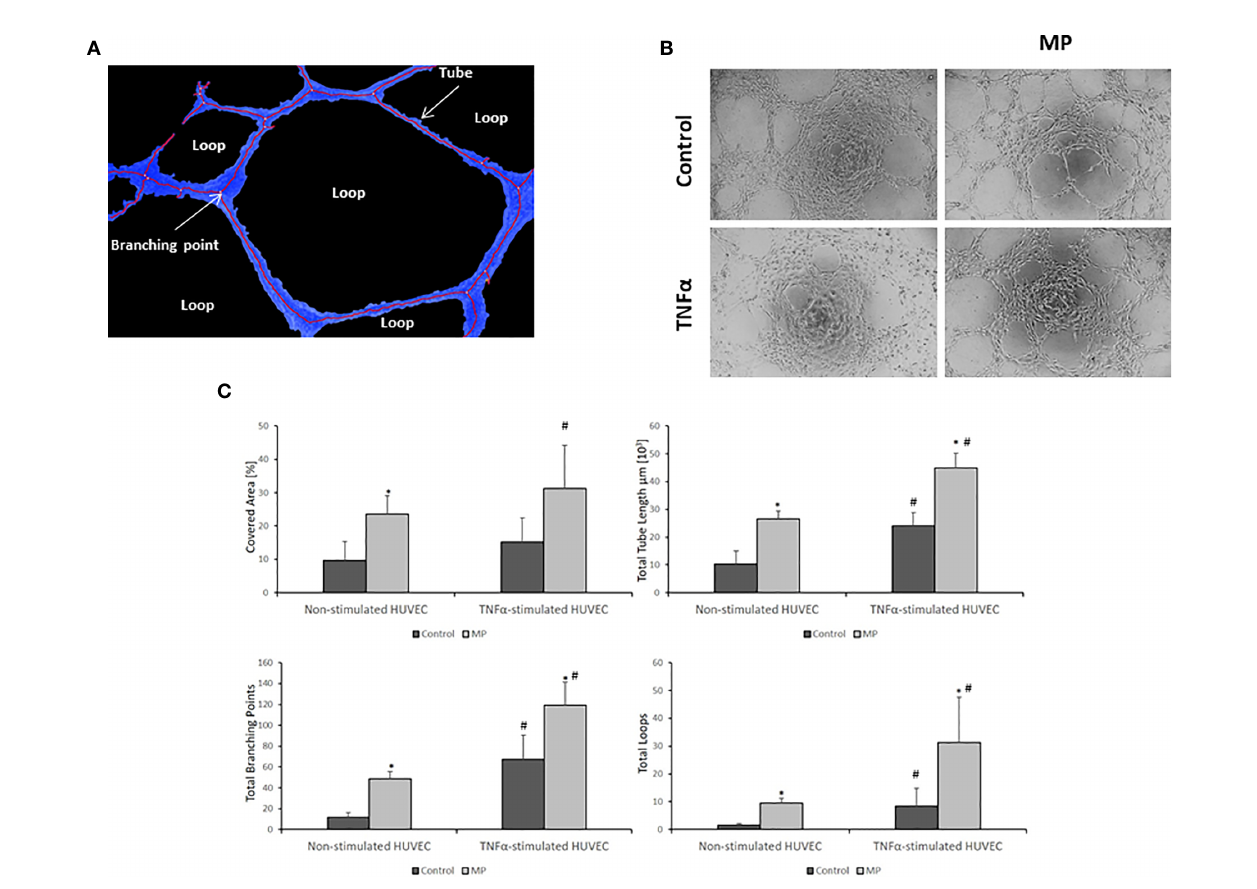
FIGURE 8 | MP induce angiogenesis in Non- and TNF a Stimulated conditions. (A) Analysis and identi fi cation of angiogenic features. (B) Angiogenesis assay images of Non-Stimulated and TNF a stimulated HUVEC under MP treatment. Quantitative image analysis of four angiogenic features (covered area (Blue lines), total tube length, total branching points, and the number of loops) in (C) Non-stimulated HUVEC, and TNF a stimulated HUVEC. The analysis was performed by the company WIMASIS. *p < 0.05 compared with the control (no MP). # p < 0.05 respect to Non-Stimulated